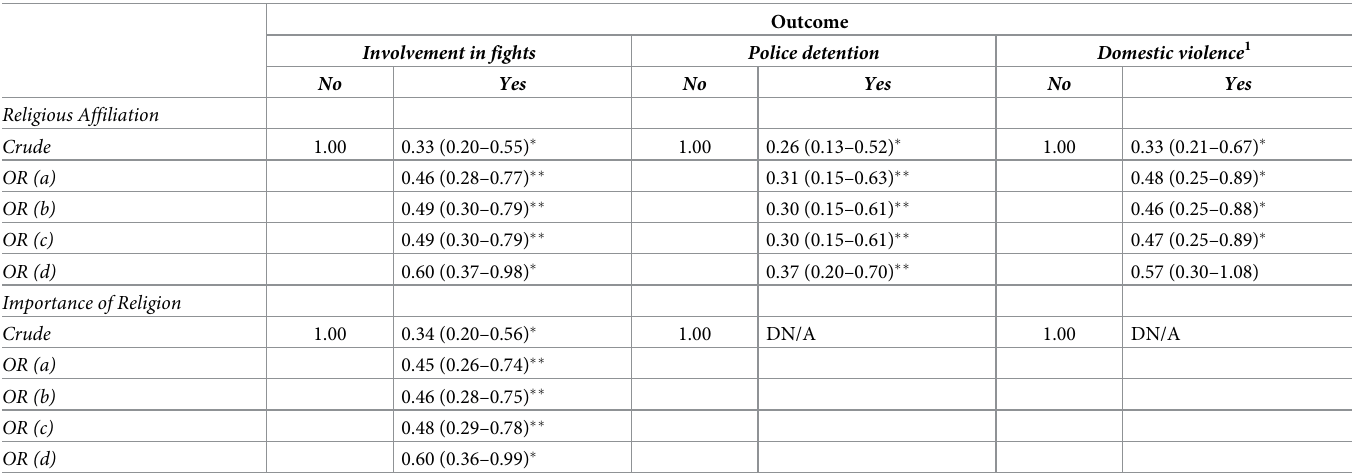
Table 3. Associations between different outcomes of violence and